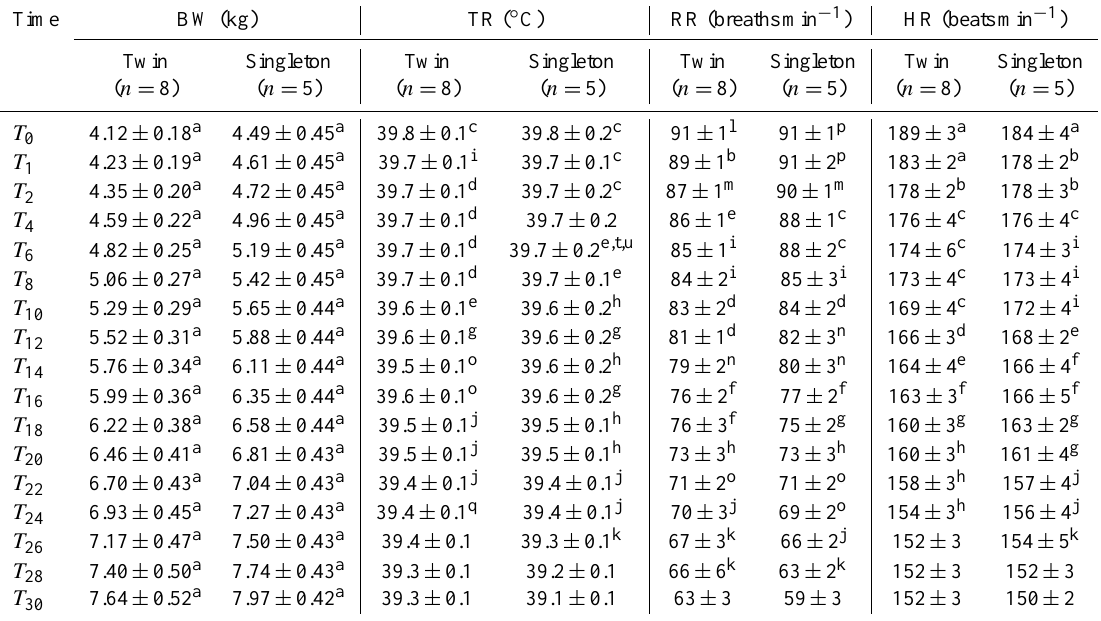
Table 1. Mean ± standard deviation of body weight (BW), rectal temperature (TR), respiratory rate (RR) and heart rate (HR) values measured in twin and singleton lambs at each time point ( T 0 – T 30 ) of experimental